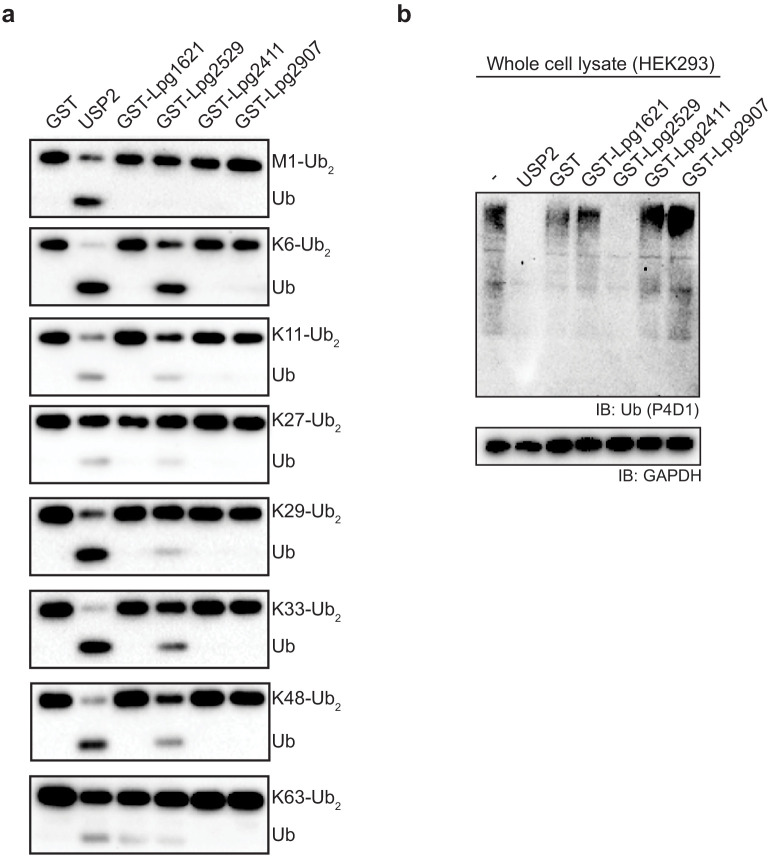
Ubiquitin cleavage assay with putative deubiquitinases (DUBs) from Legionella.(a) Di-ubiquitin species were incubated with putative Legionella DUBs and analyzed by immuno-blotting with ubiquitin antibody. (b) HEK293 cell lysates were treated with purified Legionella DUBs and analyzed by immuno-blotting with indicated antibodies.